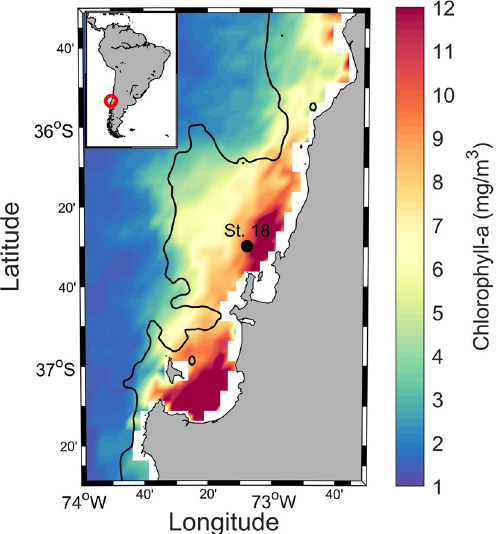
Figure 1. Geographical location of the study site at Station 18, off Concepción in central Chile. Color scale represents the average chlorophyll-a concentration observed between November 2009 and January 2011. The black solid line shows the 200 m isobath. The map was generated using Ocean Data View 40 ).